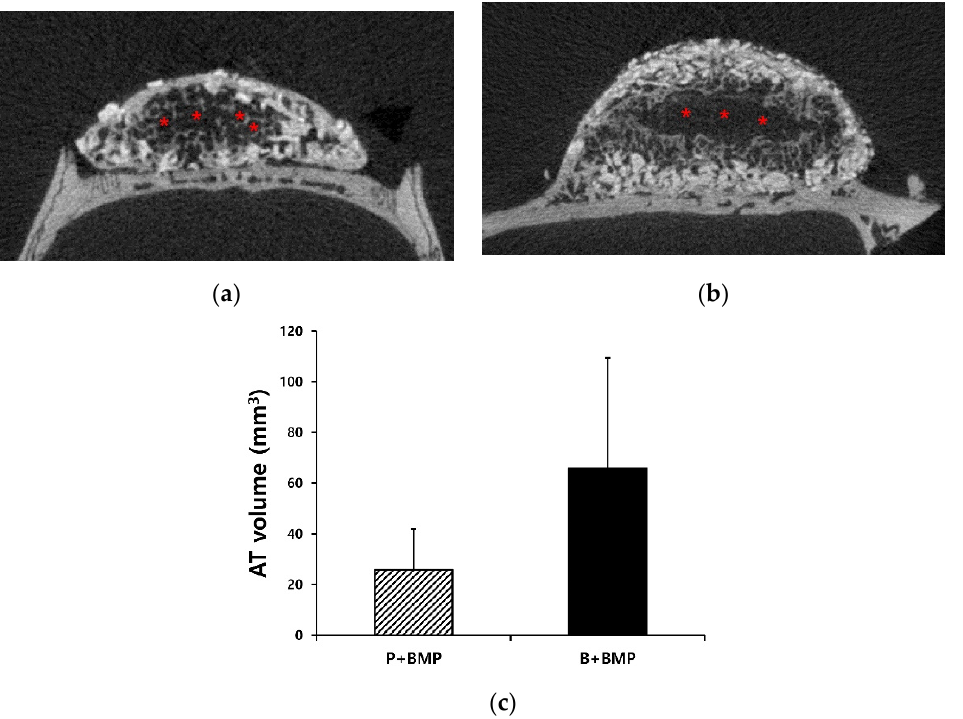
Figure 4. Micro-computed tomography images and volumes of the adipose tissue (AT) in the particle (P)+ bone morphogenetic protein (BMP) and block (B)+BMP groups. ( a ) Void space formation in the P+BMP group, ( b ) vacant space in the central area of the bone scaffold in the B+BMP group. ( c ) The average AT volumes of the P+BMP and B+BMP groups were 25.87 ± 16.03 and 65.81 ± 43.65 mm 3 ( p = 0.063). Red asterisks = adipose tissue.